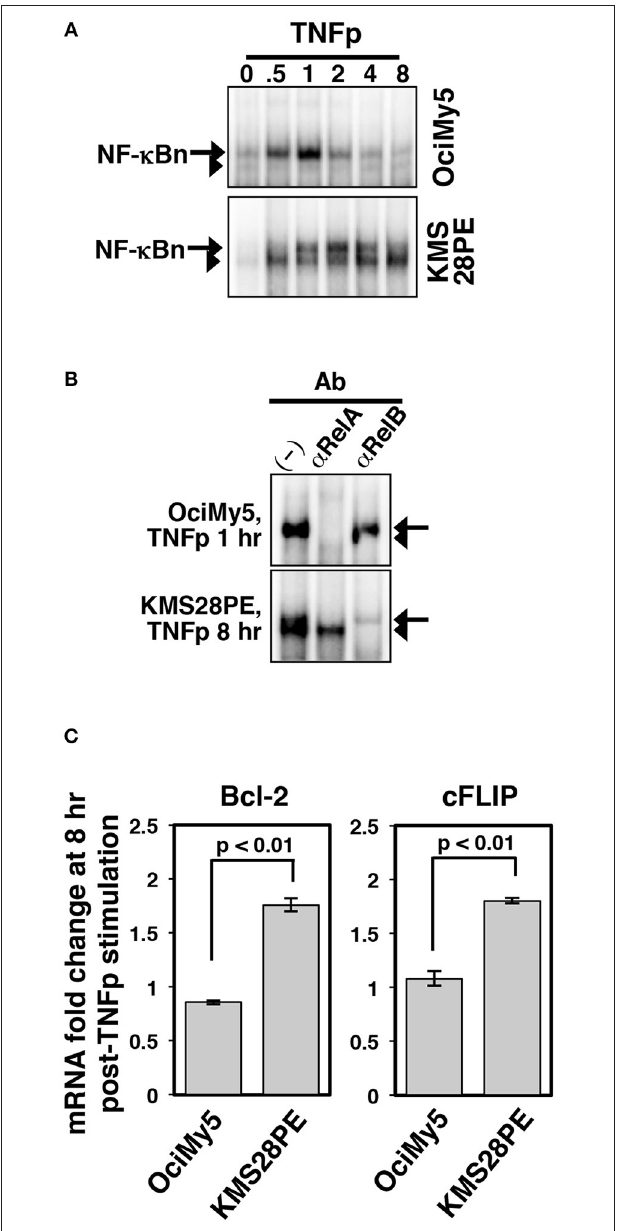
FIGURE 8 | Altered dynamical NF- κ B control in p100-deficient myeloma cells. (A) EMSA demonstrating NF- κ Bn activation upon brief TNF stimulation of the indicated human myeloma cell-lines. (B) The composition of the NF- κ Bn activities induced at 8h post-TNFp stimulation in these myeloma cell-lines was determined by shift-ablation assay. (C) qRT-PCR revealing the expression of the indicated pro-survival genes in myeloma cells at 8h post-TNFp treatment. The data represent means ± SEM of three biological